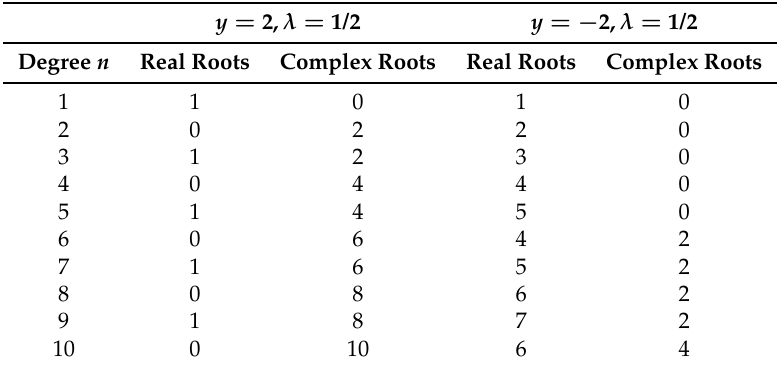
Table 1. Numbers of real and complex roots of H n ( x , y , λ ) = 0.